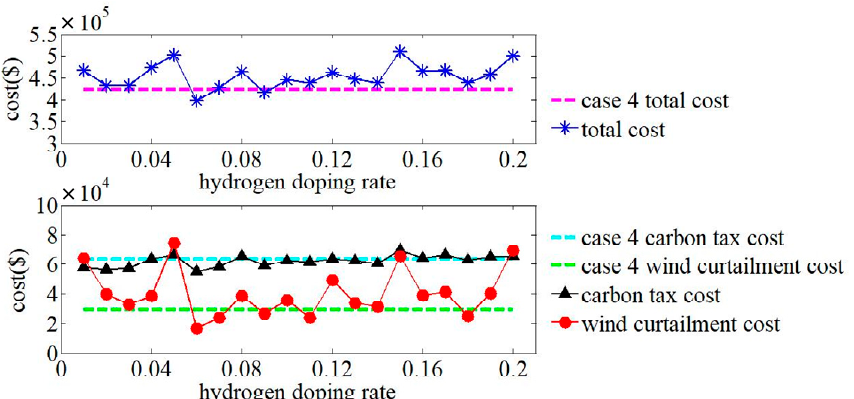
Figure 11. Operation results of different hydrogen mixing rates in Case 4. In the figure, the blue curve drawn by asterisk connection, the black curve drawn by triangle connection and the red curve drawn by circular connection, respectively, represent the total cost, the carbon tax cost and the wind abandonment cost of Case 4 under different hydrogen mixing rates. The purple dotted line, the blue dotted line and the green dotted line, respectively, represent the total cost value, the carbon tax cost value and the wind abandonment cost value of Case 4 under the flexible hydrogen mixing model.